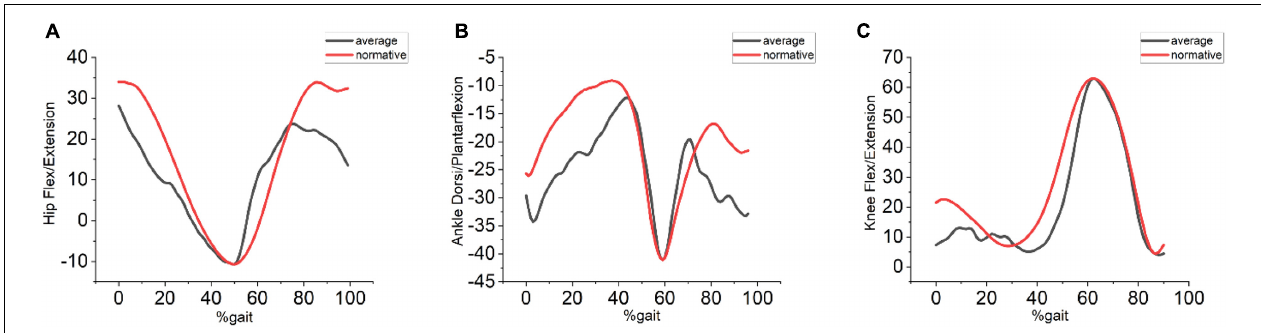
FIGURE 3 | (A) Hip flexion/extension (B) Ankle dorsi/plantarflexion (C) Knee flexion/extension. Average values of all the subjects data using the proposed system shown in blue color and the average values from all the subjects from the gait database shown in red color.